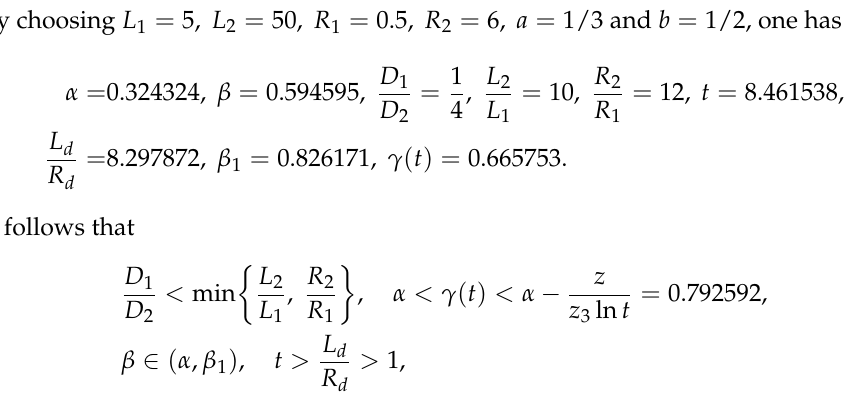
Figure 2. Identification of critical potentials V 2 and V s 1 c and approximation of J 1 for ε =